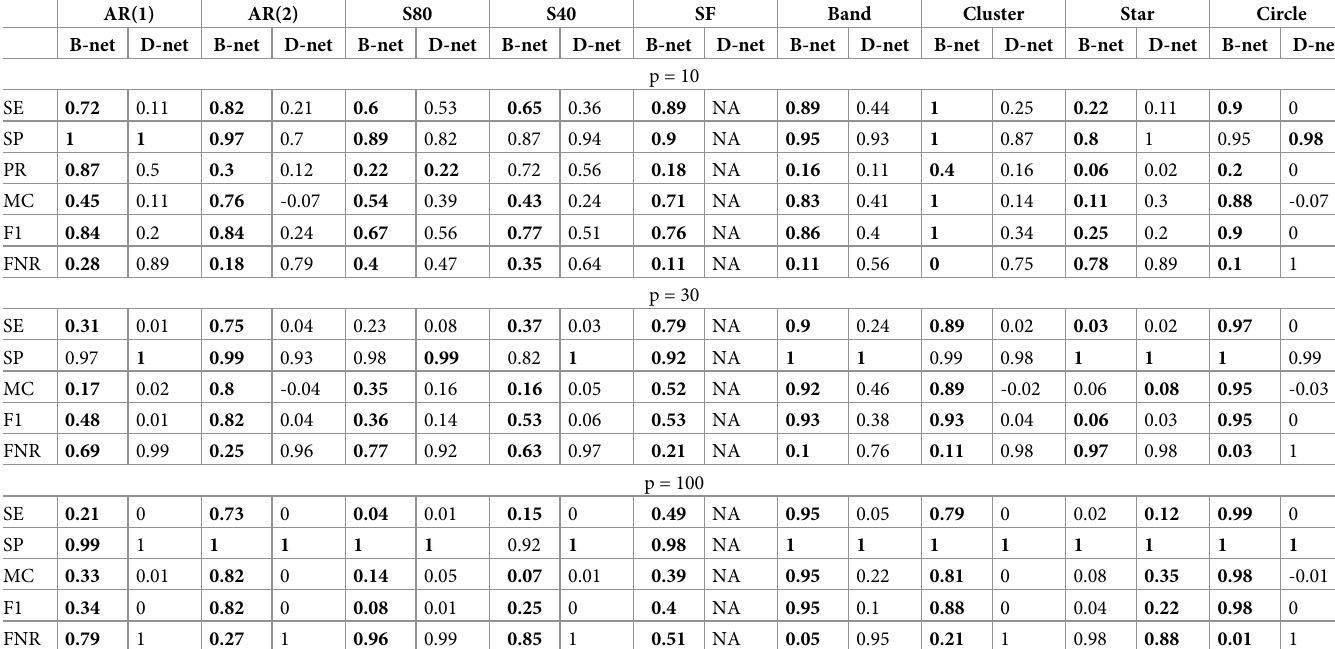
Table 5. Synthetic study median performance